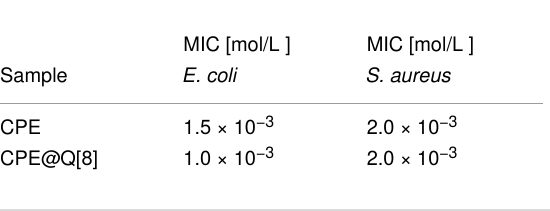
Table 3: The minimum effective concentration (MIC) of CPE, CPE@Q[8] against E. coli and S. aureus